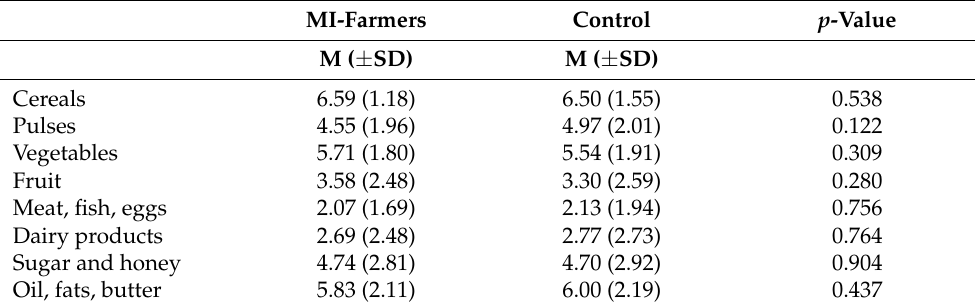
Table 5. Difference in food group consumption—MI and control group—mean number of days in a week when household members consumed a particular food group.